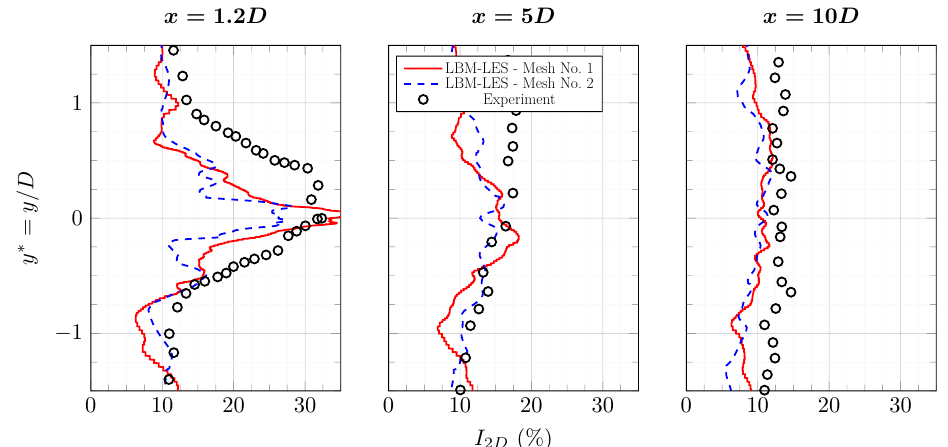
Figure 20. Average turbulence intensity profiles I 2 D in the wake of the tidal turbine at TSR = 3.67 and I = 12.5%. Results are from experiment [6] and from LBM-LES simulations with mesh Nos. 1 and 2. The complete set of profiles is in Appendix B.